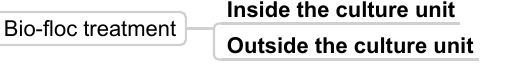
Figure 11. Partial taxonomy: Bio-floc